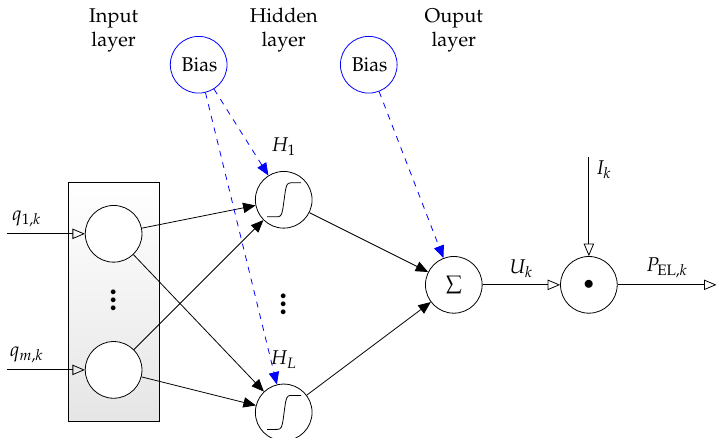
Figure 2. Static neural network model for the electric power characteristic of the SOFC stack with the network inputs ϑ m, ( 1,1,1 ) , k , ϑ m, ( 1,3,1 ) , k , I k , ϑ CG,m, k , ˙ m N